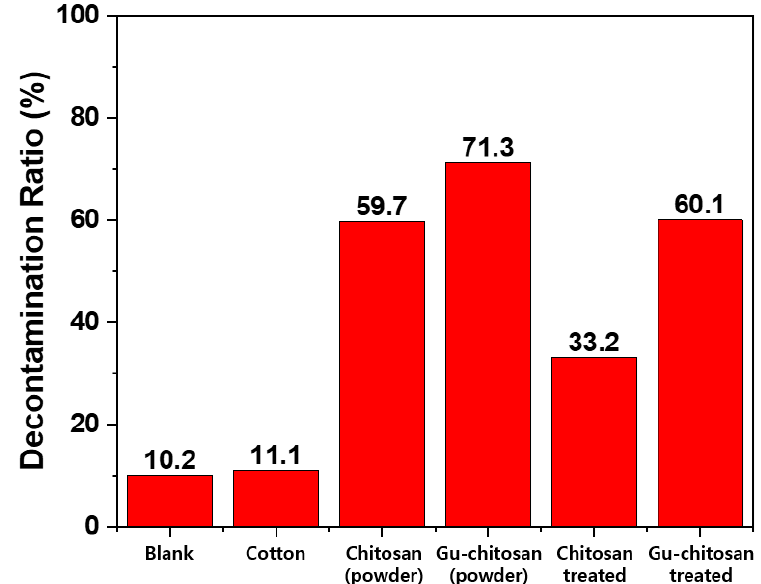
Figure 10. DFP decontamination properties of the prepared samples obtained by GC chromatograms.